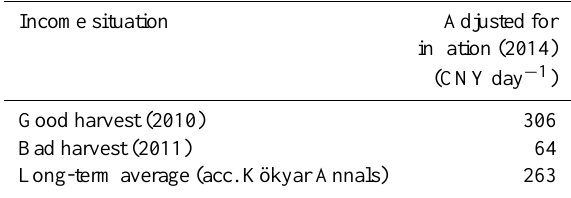
Table 5. Averaged annual incomes of and cost to Kökyar I farmers. Income and cost item